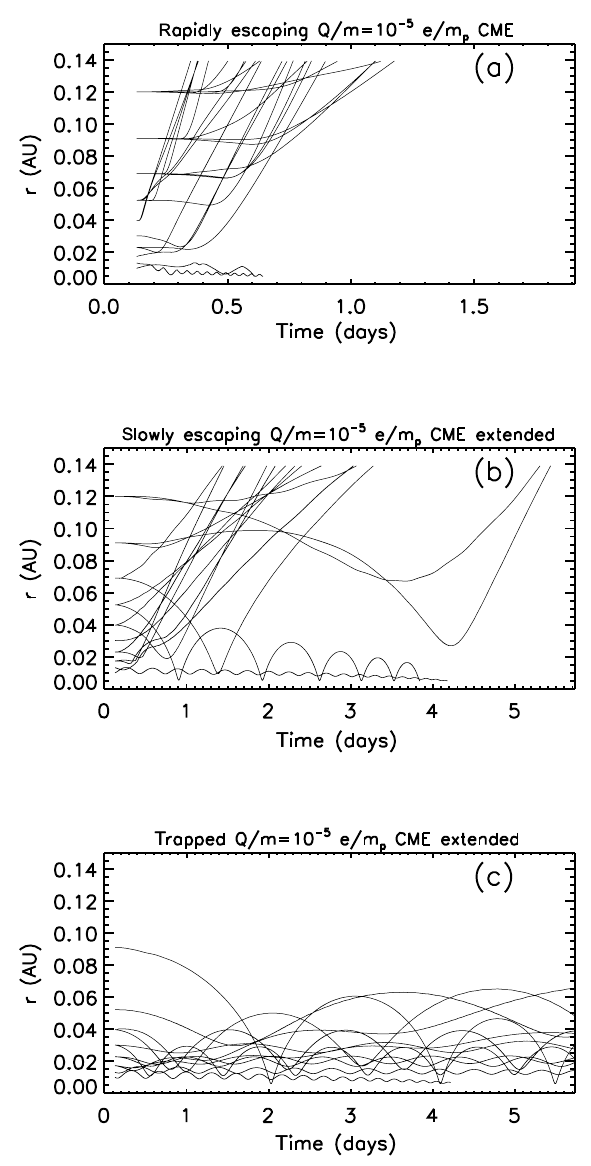
Figure 15. Distance versus time plots for a sample of trajecto- ries of the nanodust particles ( Q/m = 10 − 5 e/m p ) belonging to (a) “rapidly escaping”, (b) “slowly escaping”, and (c) “trapped” popu-